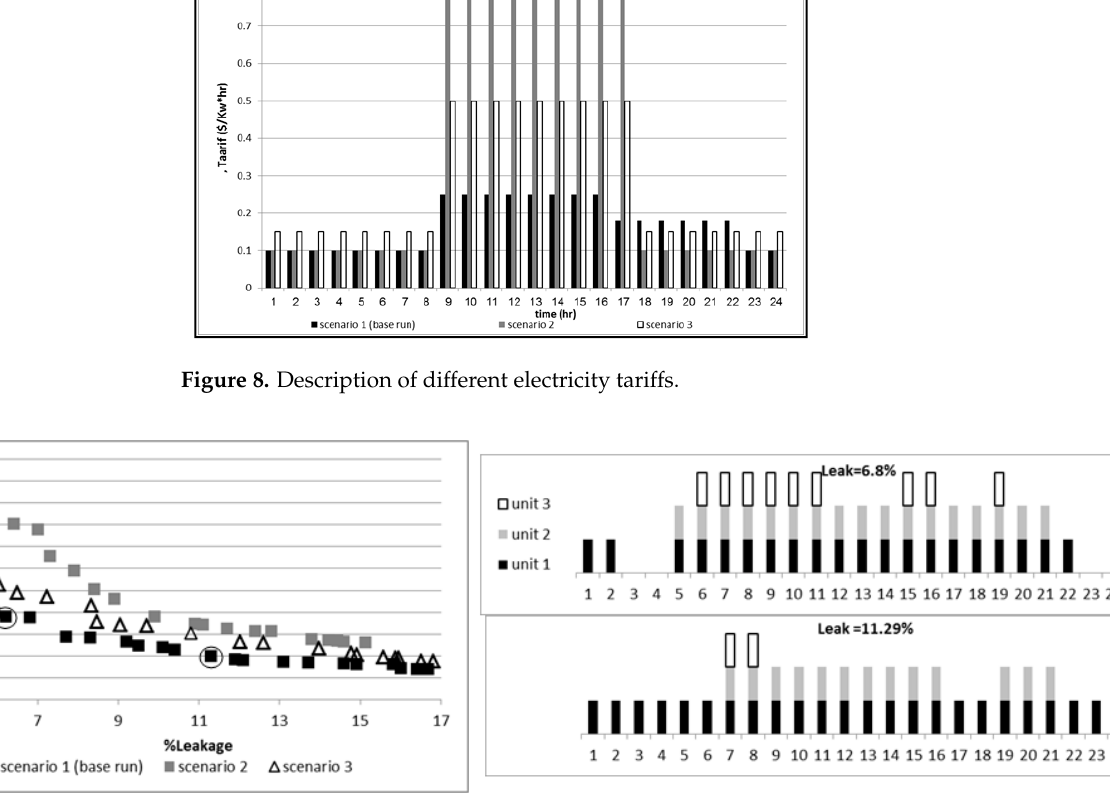
Figure 9. Base run and sensitivity analysis results for different electricity scenarios in net 1-c. Two examples of the pump scheduling solution for two representing points are (circled) presented on the right.